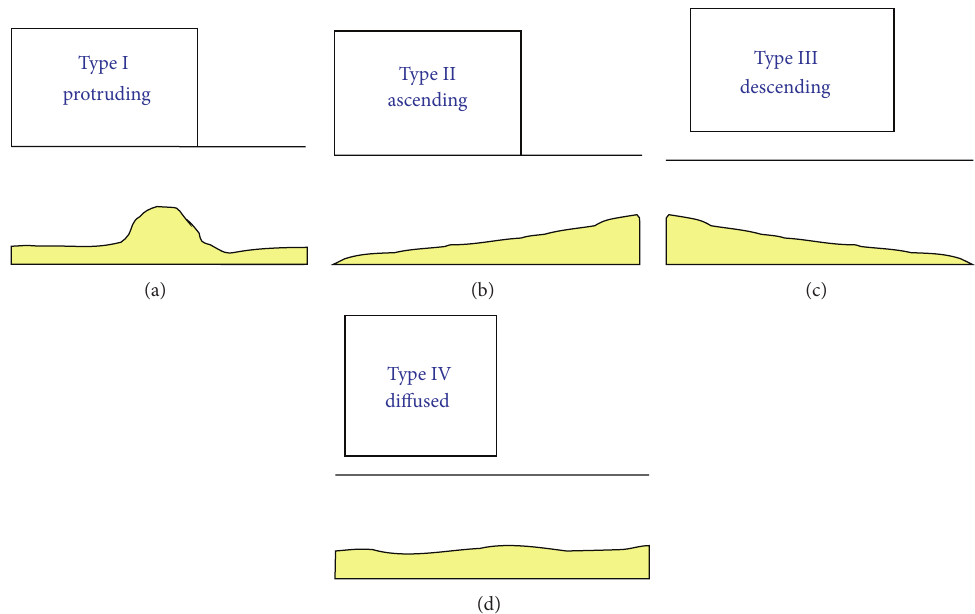
Figure 1: Fuzzy logic analysis of the plaque measurements for 42 patients has revealed four distinct patterns: (a) Type I (protruding), (b) Type II (ascending), (c) Type III (descending), and (d) Type IV